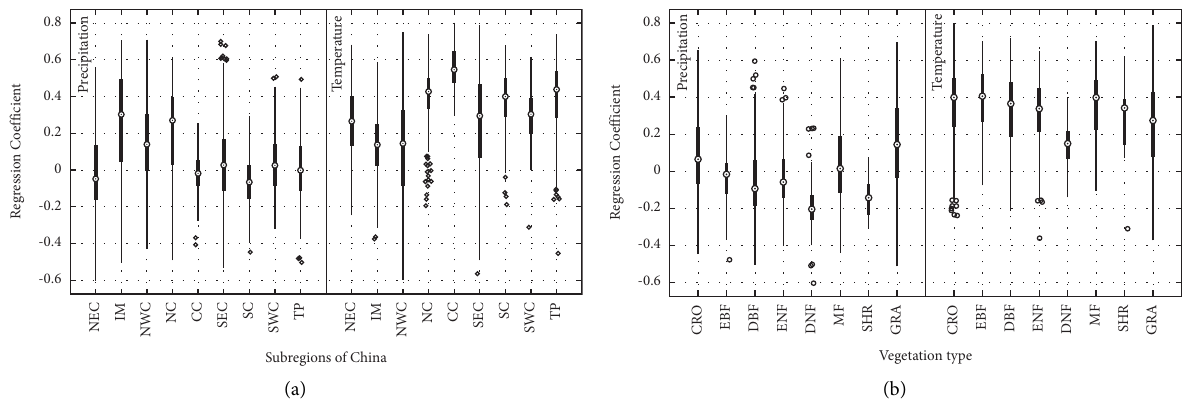
Figure 3: Average regression coefficients of climate variables (precipitation and temperature) for (a) each subregion and (b) vegetation